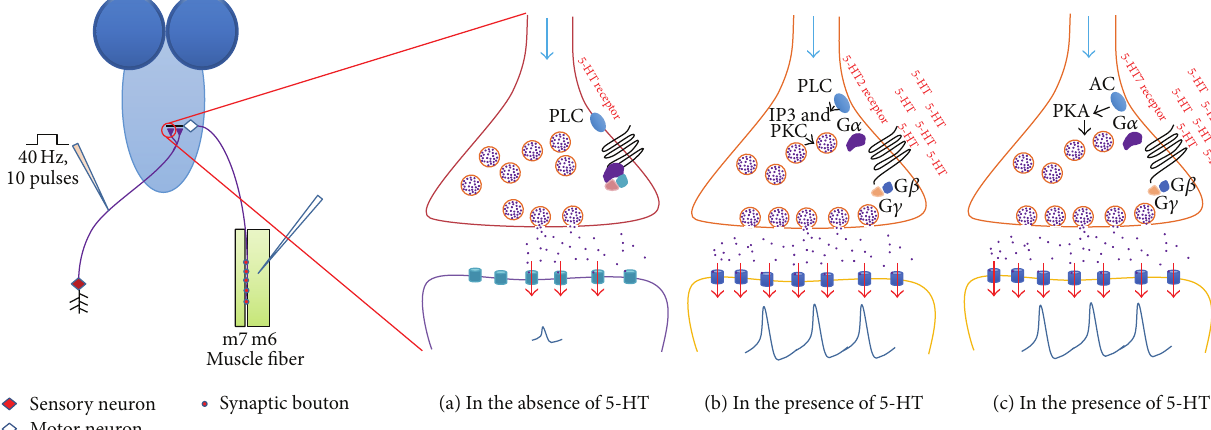
Figure 18: Hypothetical model for the modulatory action of 5-HT in sensory-CNS-motor neural circuitry in Drosophila larvae. (a) 5-HT2 receptors are located in the membrane of the presynaptic terminal. In the absence of 5-HT, the strength of synaptic transmission is weak. (b) 5-HT application results in the activation of 5-HT2 receptors which enhances the synaptic transmission due to increment in probability of vesicles release. (c) The activation of 5-HT7 receptors by the 5-HT or 5-HT agonist might activate adenylyl cyclase (AC) starting a cascade of cellular